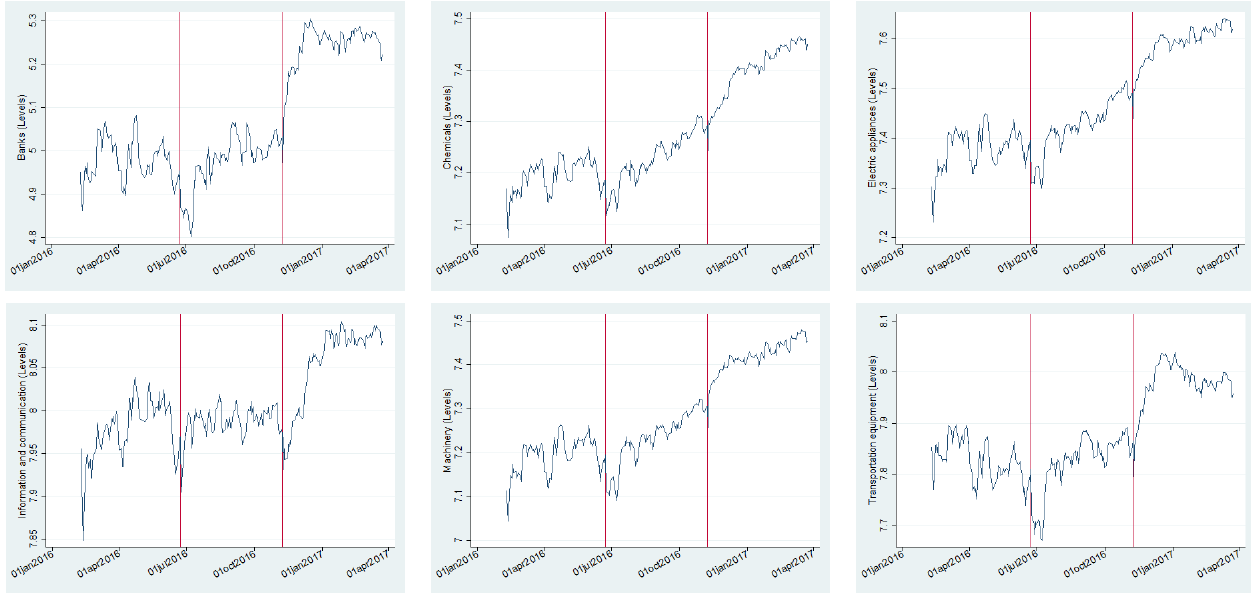
Figure 2. Levels of sectoral indices. Author’s estimations based on the data from the TSE. The levels are the logarithmic values of the variables.